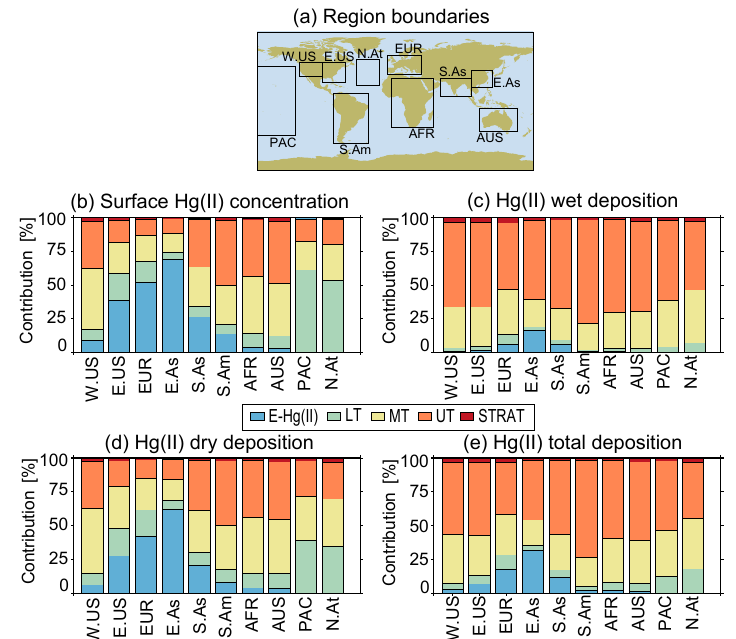
Figure 6. (a) Boundaries and names for regions used in panels (b–e) . Regional contributions of tagged Hg(II) tracers to (b) Hg(II) surface concentrations, (c) Hg(II) wet deposition, (d) Hg(II) dry deposition, and (e) Hg(II) total (wet + dry) deposition. For continental regions the averages are calculated over land